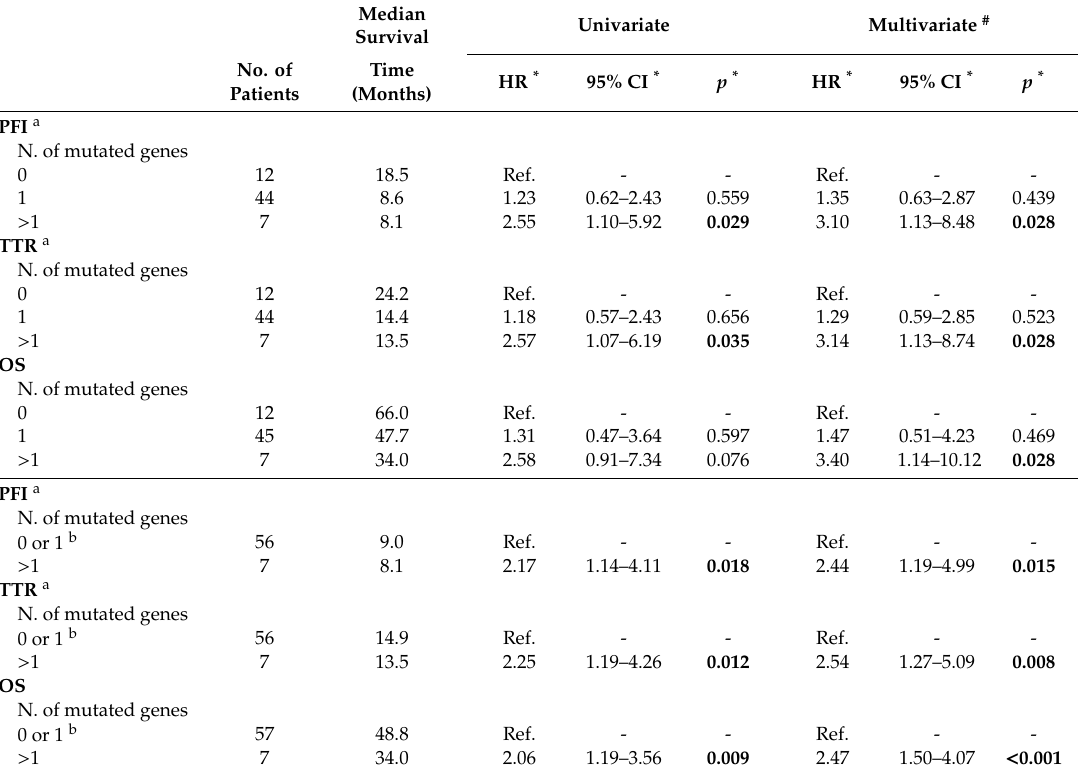
Table 3. Associations between number of mutated genes and outcomes in patients with HGSOC. Median Univariate Multivariate # Survival No. of Time HR Patients (Months)